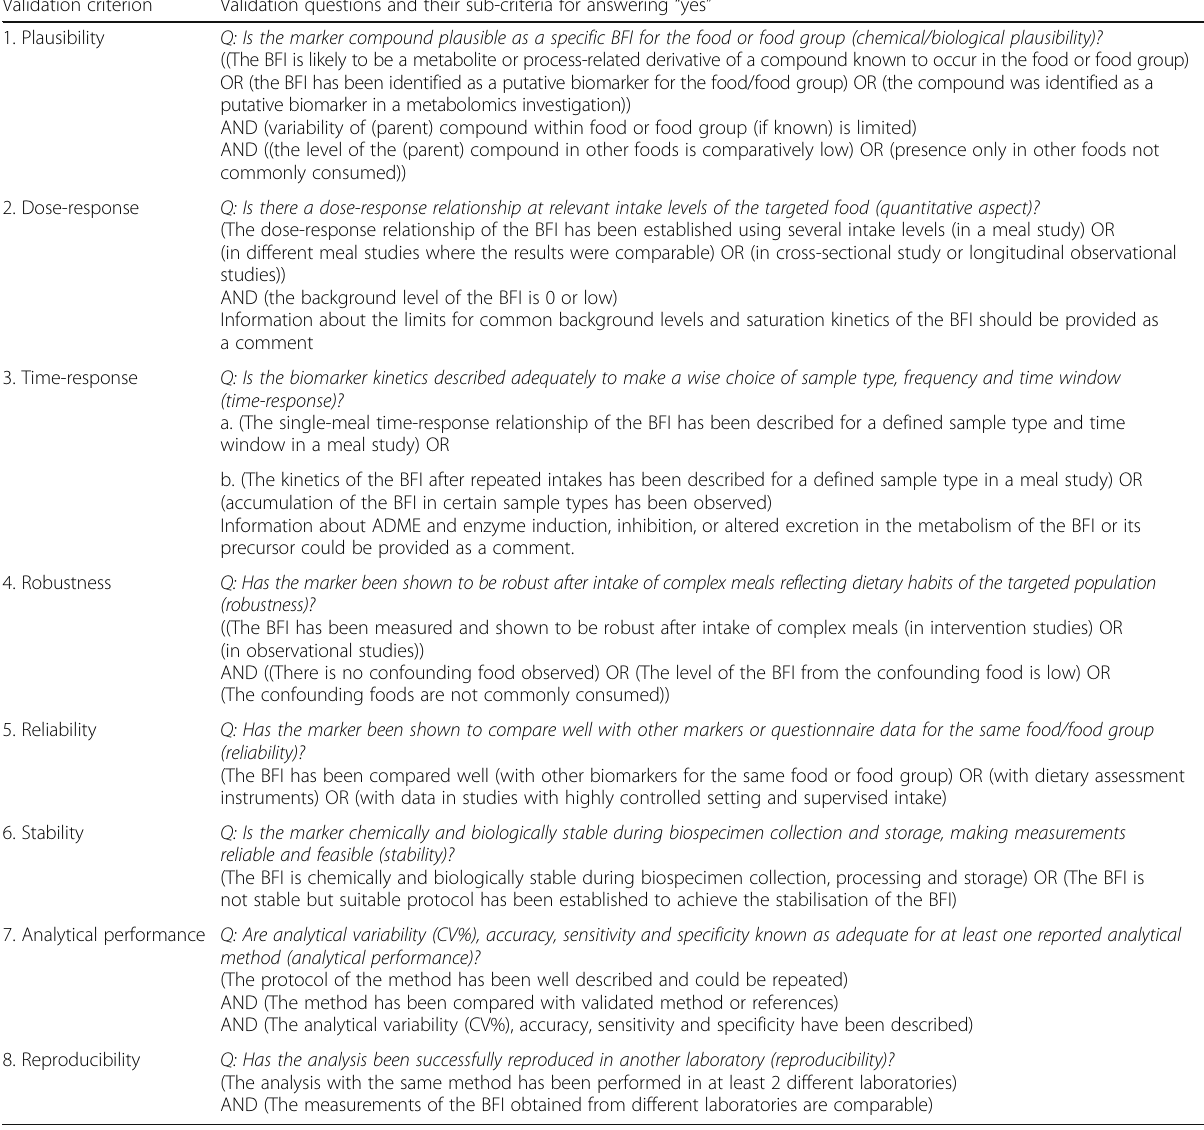
Table 2 Eight groups of validity criteria for biomarkers of food intake Validation